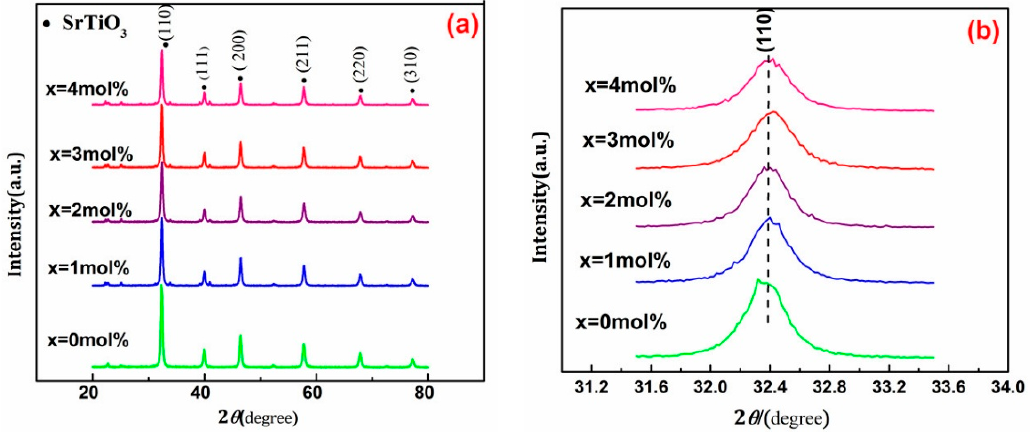
Figure 6. XRD pattern of pure and 1 mol %, 2 mol %, 3 mol %, 4 mol % Ce 4+ doped SrTiO 3 . ( a )The whole XRD pattern; ( b ) The local enlargement of the diffraction peaks at 2 θ = 32.4 ° .